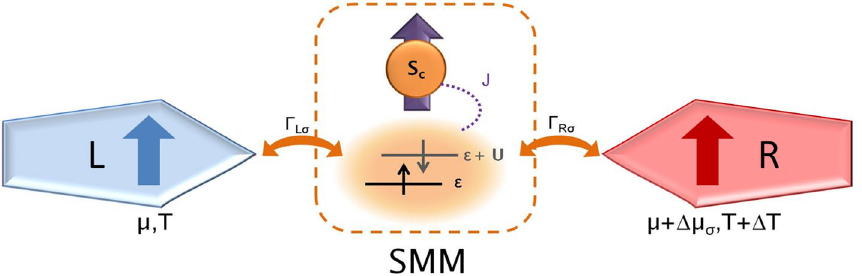
Figure 1. Schematic of the considered molecular junction. It consists of a magnetic molecule of spin S = S c + s tunnel-coupled to external leads, with spin-dependent coupling strengths, Ŵ L σ and Ŵ R σ , for the left and right lead. S c is the spin of the molecule’s magnetic core, while s denotes the spin of electrons occupying the orbital level. The molecule is assumed to effectively possess one orbital level, through which transport takes place, that is exchange-coupled (with coupling strength J ) to the molecule’s core spin S c . The orbital level is characterized by on-site energy ε and the Coulomb correlations U . There is a voltage ( �µ σ ) and temperature ( (cid:31) T ) gradient applied to the system. In the case of magnetic contacts, the voltage gradient may be spin-dependent. In considerations we assume S c = 1 , while s = 1 / 2 ( s = 0 ) when the orbital level occupancy is odd